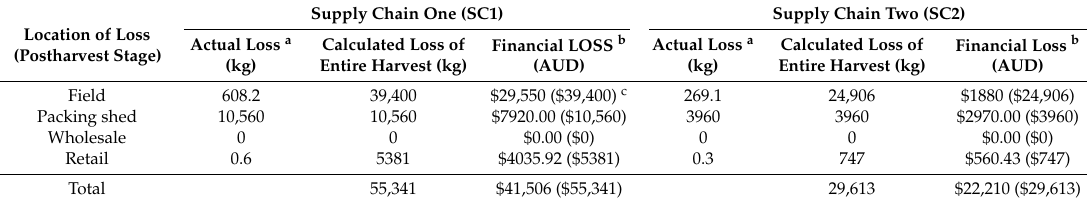
Table 5. Actual, calculated full day’s postharvest losses (kg) and estimated economic loss and potential market value along the supply